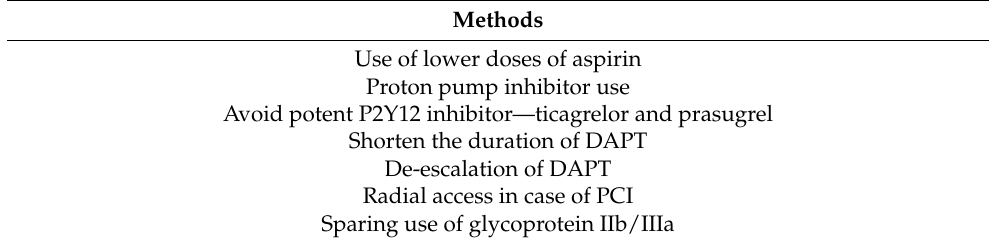
Table 4. Methods to mitigate bleeding risk with a combination of antiplatelet and anticoagulant